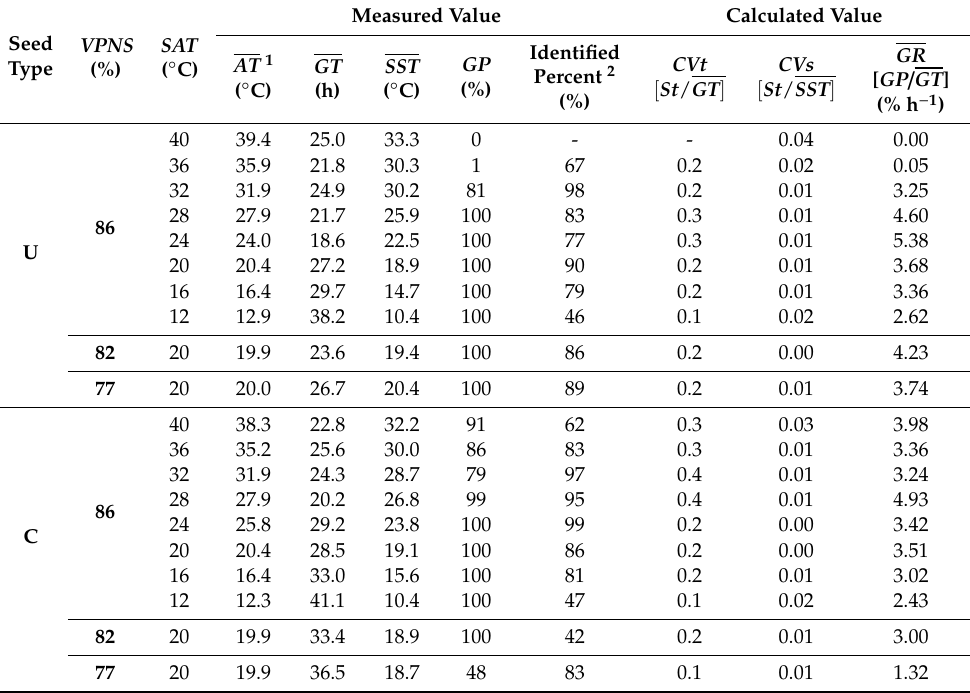
Figure 7. Average seed surface temperature ( SST ) and average air temperature ( AT ) under di ff erent setpoint air temperature ( SAT ) (12, 16, 20, 24, 28, 32, 36, 40 ◦ C) and volumetric percentage of nutrient solution in seed tray ( VPNS ) of 86%, each with 300 uncoated seeds (U) and coated seeds (C). Some data of AT include the average temperature of a shorter time period than 48 h. Table3. Averageairtemperature( AT ), averagegerminationtime( GT ), averageseedsurfacetemperature ( SST ), germination percentage per 300 seeds 48 h after sowing ( GP ), Identified percent, and coe ffi cient of variation of germination time ( CVt ) and seed surface temperature ( CVs ) together with average hourly germination rate per 300 seeds ( GR ), each with di ff erent volumetric percentage of nutrient solution in seed tray ( VPNS ), setpoint air temperature ( SAT ), and uncoated seed (U) / coated seed (C). (see Table 1 for